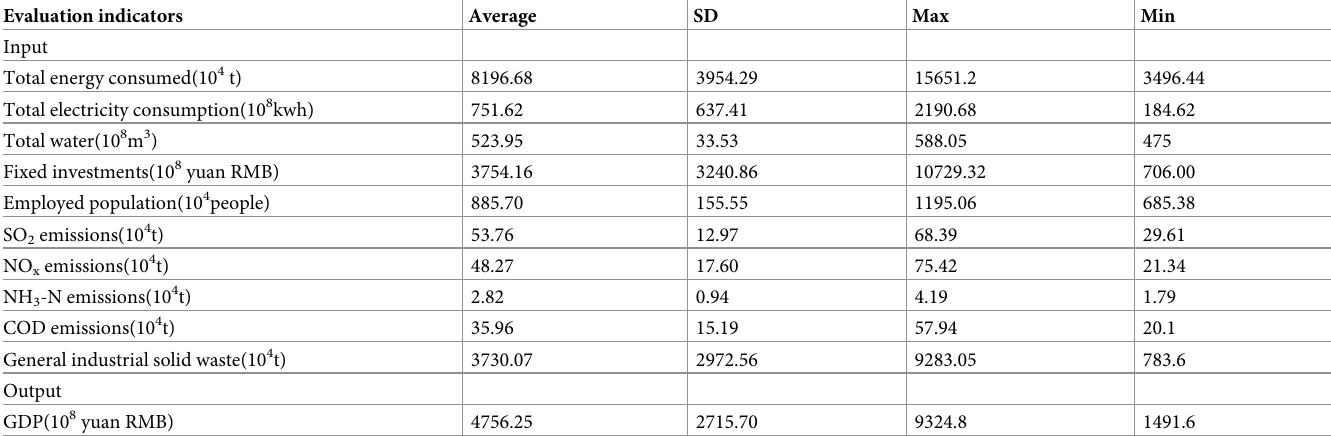
Table 1. Evaluation indicators and statistical data used in eco-efficiency